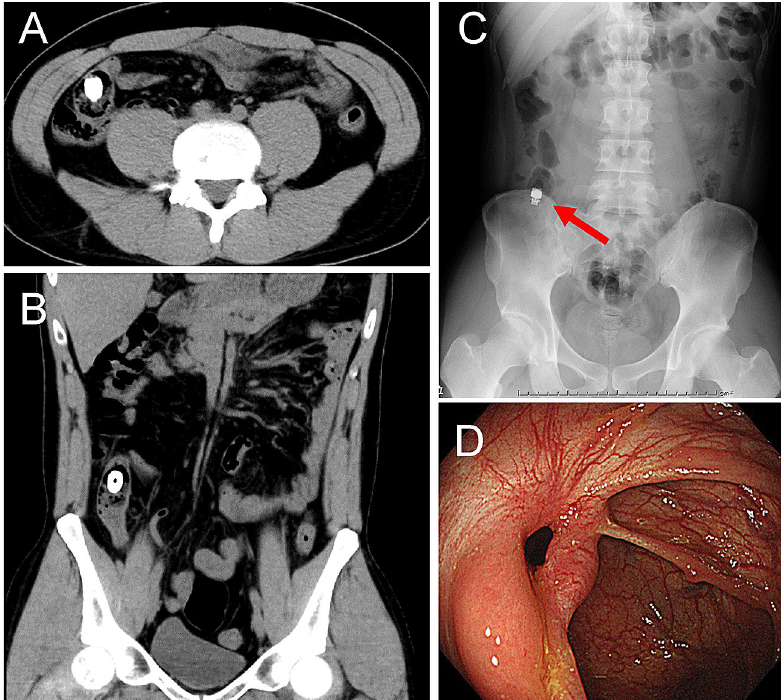
Figure 3. SBCE retention case caused by CT misjudgement of PC in a patient with Crohn’s disease. Plain computed tomography (CT) images show that the PC seemed to be in the ascending colon; axial CT image ( A ), coronal CT image ( B ). X-ray scan confirms SBCE retention (arrow) in the terminal ileum after 2 weeks ( C ). Colonoscopic image confirms ileocecal valve stenosis, which was treated with balloon dilatation ( D